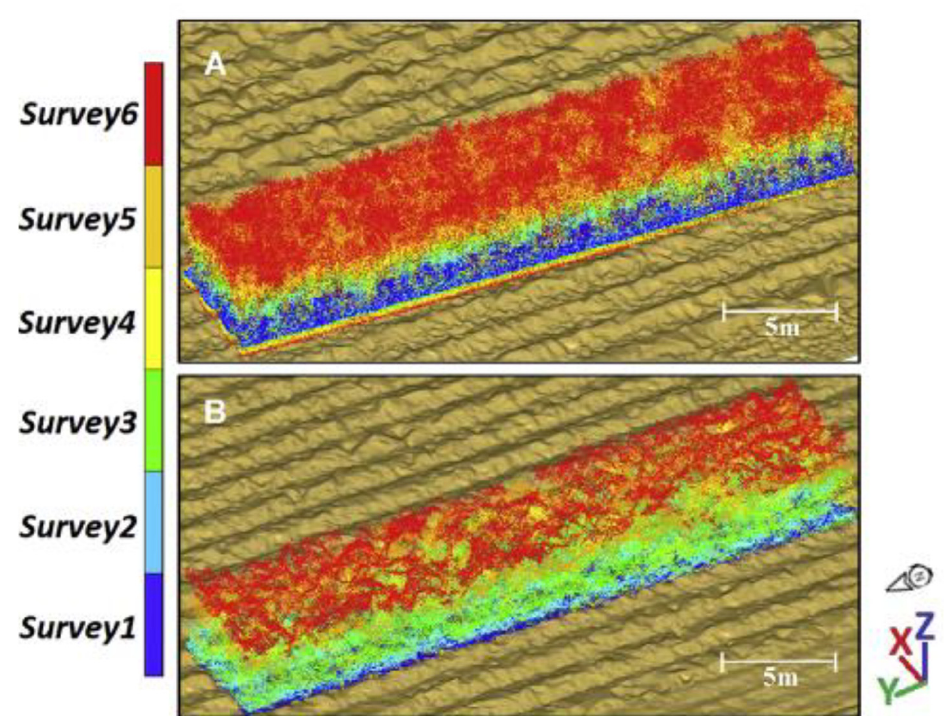
Figure 5. Example ( A ) LiDAR and ( B ) photogrammetry time-series point cloud data coloured by survey (dark blue to red). Reprint from Ref. [43].